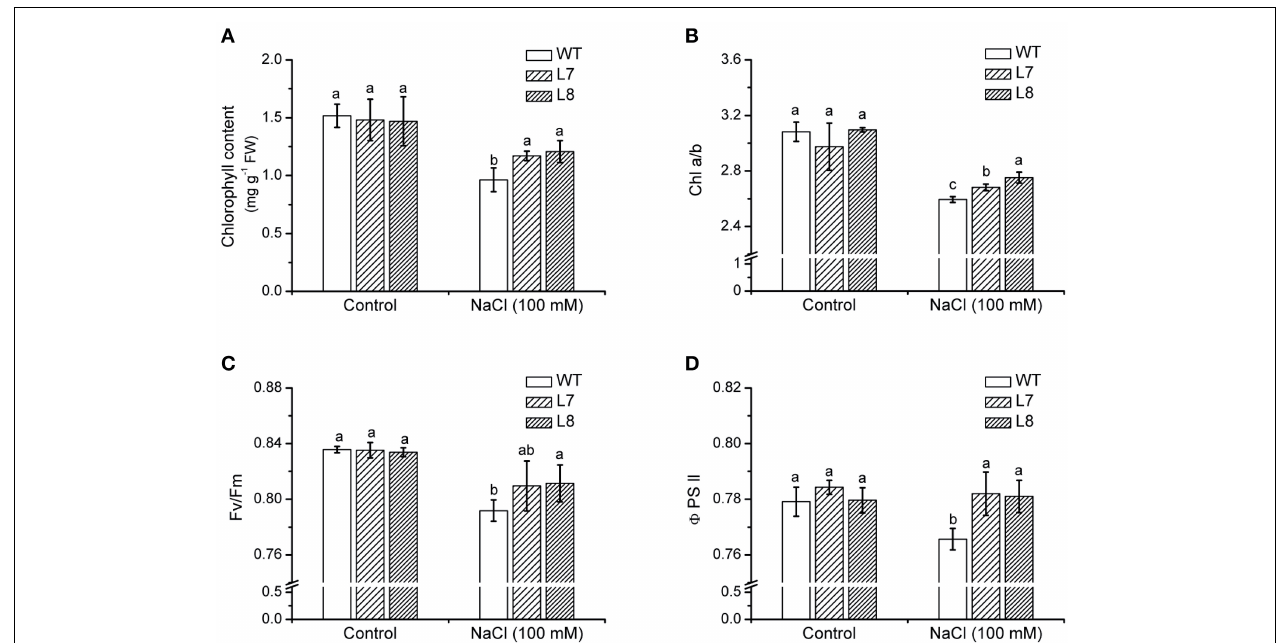
FIGURE 7 | Effects of NaCl on chlorophyll content and fluorescence in wild-type tobacco and KcCSD -transgenic lines. Four-weeks old rooted plants of wild-type (WT) and transgenic lines (L7 and L8) were transferred to 1/4 Hoagland’s nutrient solution for 2-weeks acclimation, then exposed to 0 or 100mM NaCl for 7 days. (A) Chlorophyll content, (B) Chlorophyll a/b ratio,